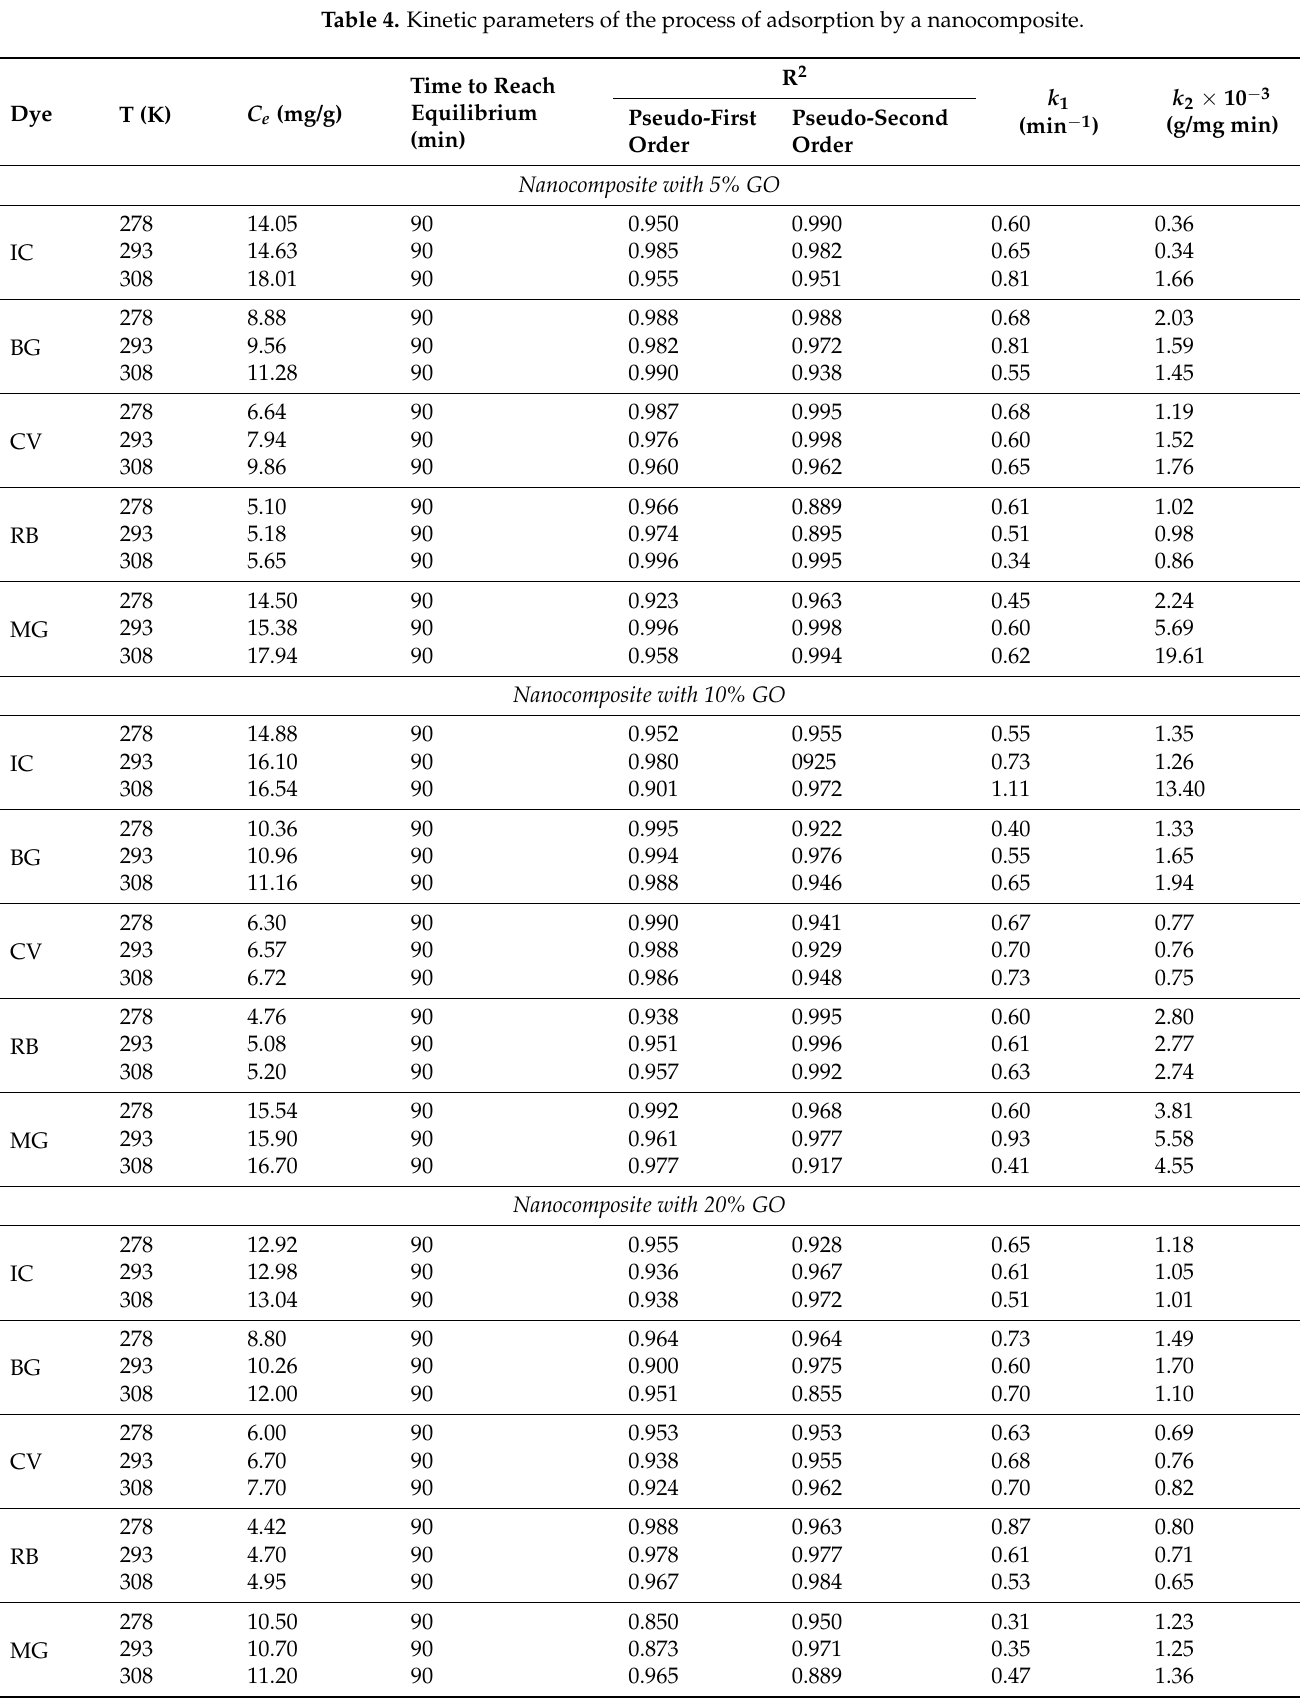
Table 4. Kinetic parameters of the process of adsorption by a